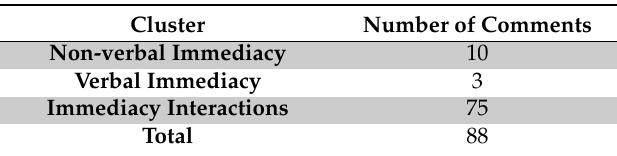
Table 4. Evaluator Comments for the